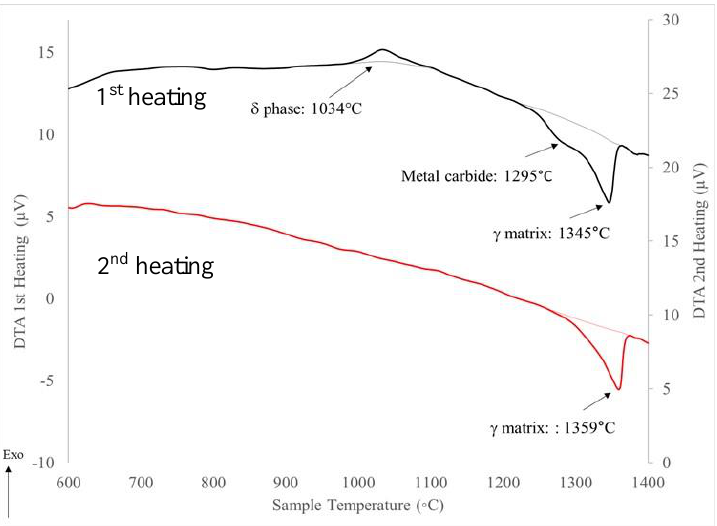
Figure 12. DTA heating cycles for ST + Age Inconel 718.